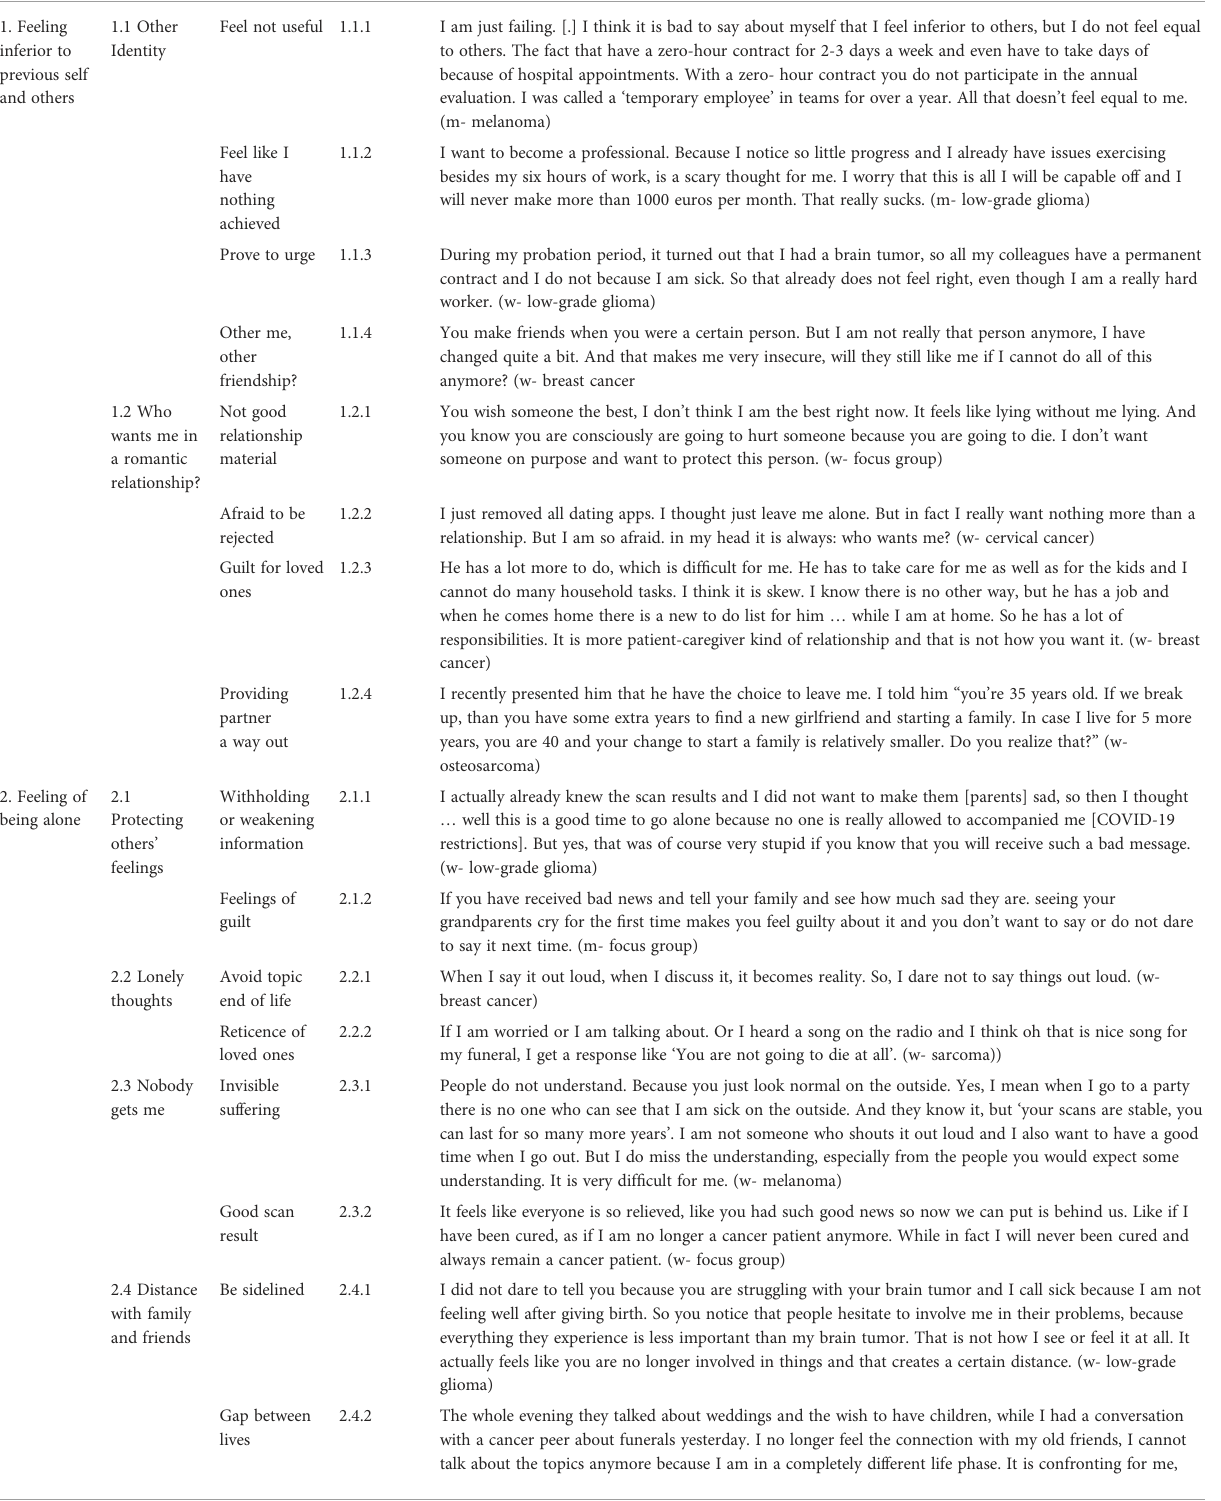
TABLE 3 Coding hierarchy. Theme Sub-